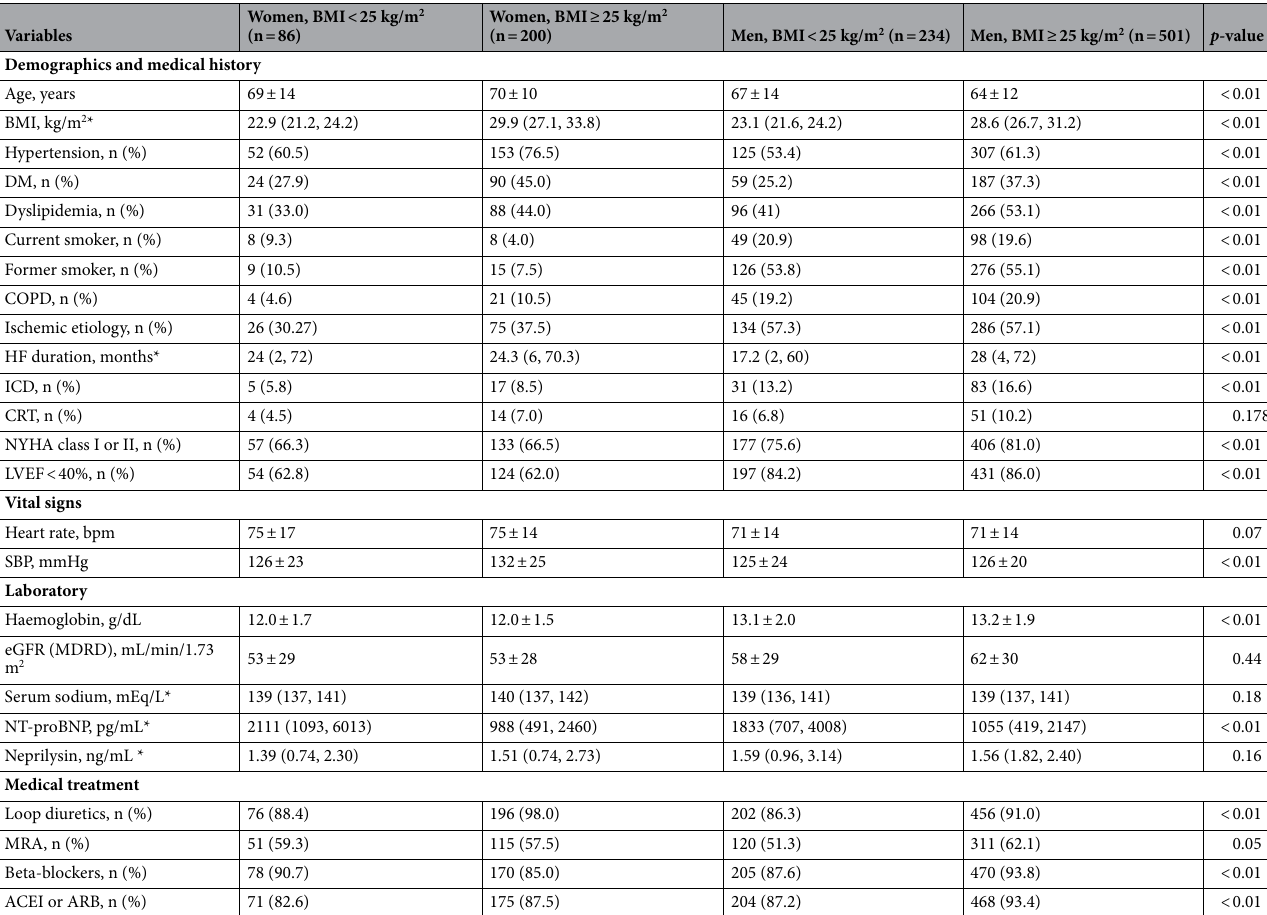
Table 1. Baseline characteristics across sex and BMI. Continuous variables are expressed as mean ± 1 standard deviation unless otherwise specified. ACEI angiotensin-converting enzyme inhibitors, ARB